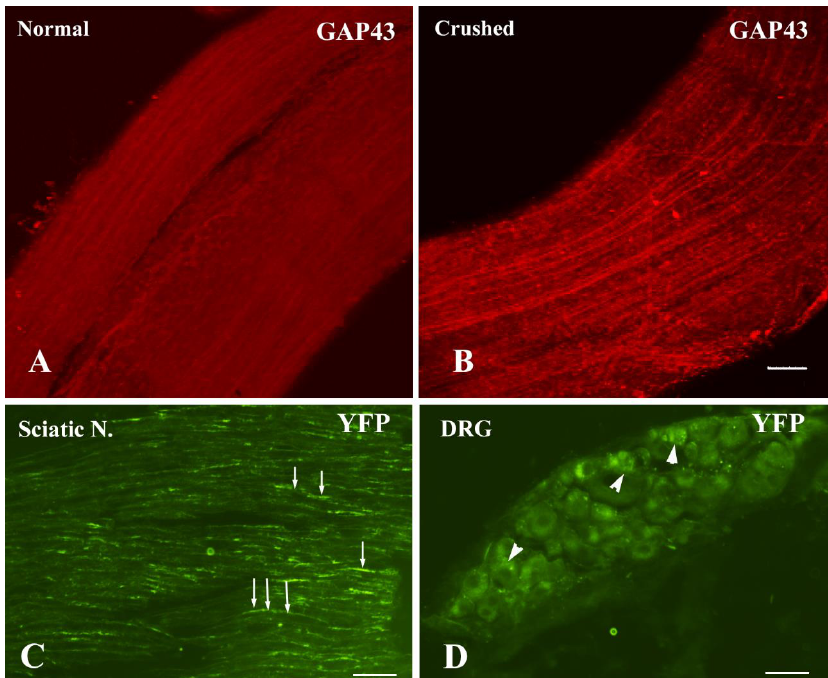
Figure 1. AAV9.hSyn.YFP application in the crushed sciatic nerve. ( A ) GAP 43 immunoreactivity is barely observed in the whole mount sciatic nerve of the sham control. ( B ) GAP 43+ nerve axons are readily seen in the proximal stump of the crushed nerve. ( C ) Some axons (arrows) in the proximal stump of the crushed sciatic nerve express YFP at 7 days after AAV9.hSyn.YFP injection into the crush site. ( D ) The neurons in the DRG (arrowheads) are transduced to express YFP. The punctate YFP signals are discerned in the cytoplasm. Scale bars: 100µm.